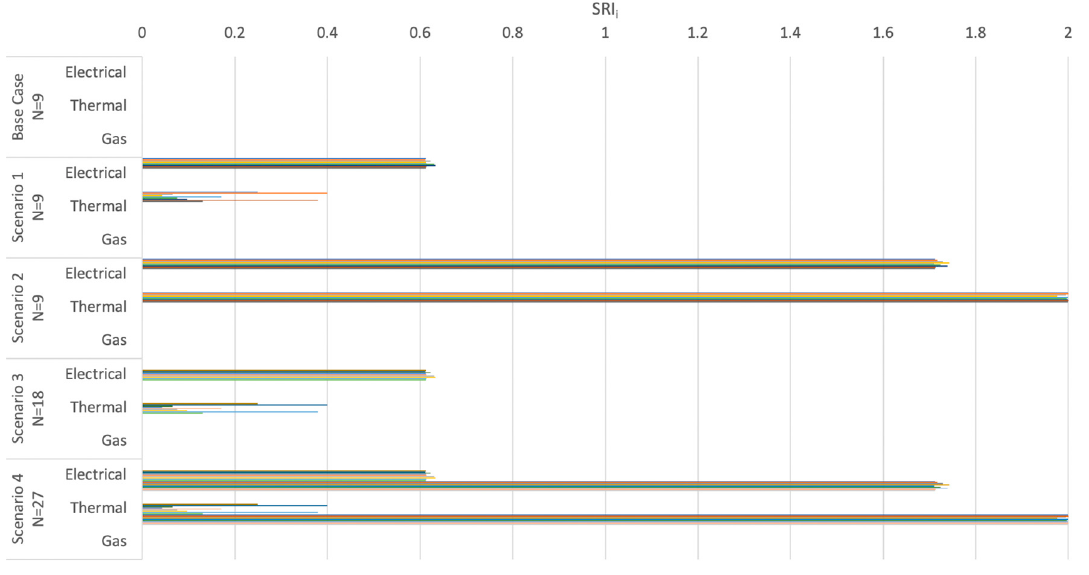
Figure 6. Smart Readiness Indicator for the individual buildings ( SRI i ) per district for the Base Case and Scenarios 1–4.